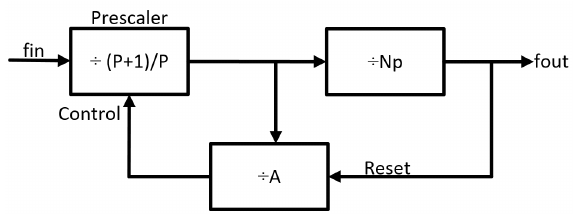
Figure 3. Programmable frequency divider (Programmable-FD) block